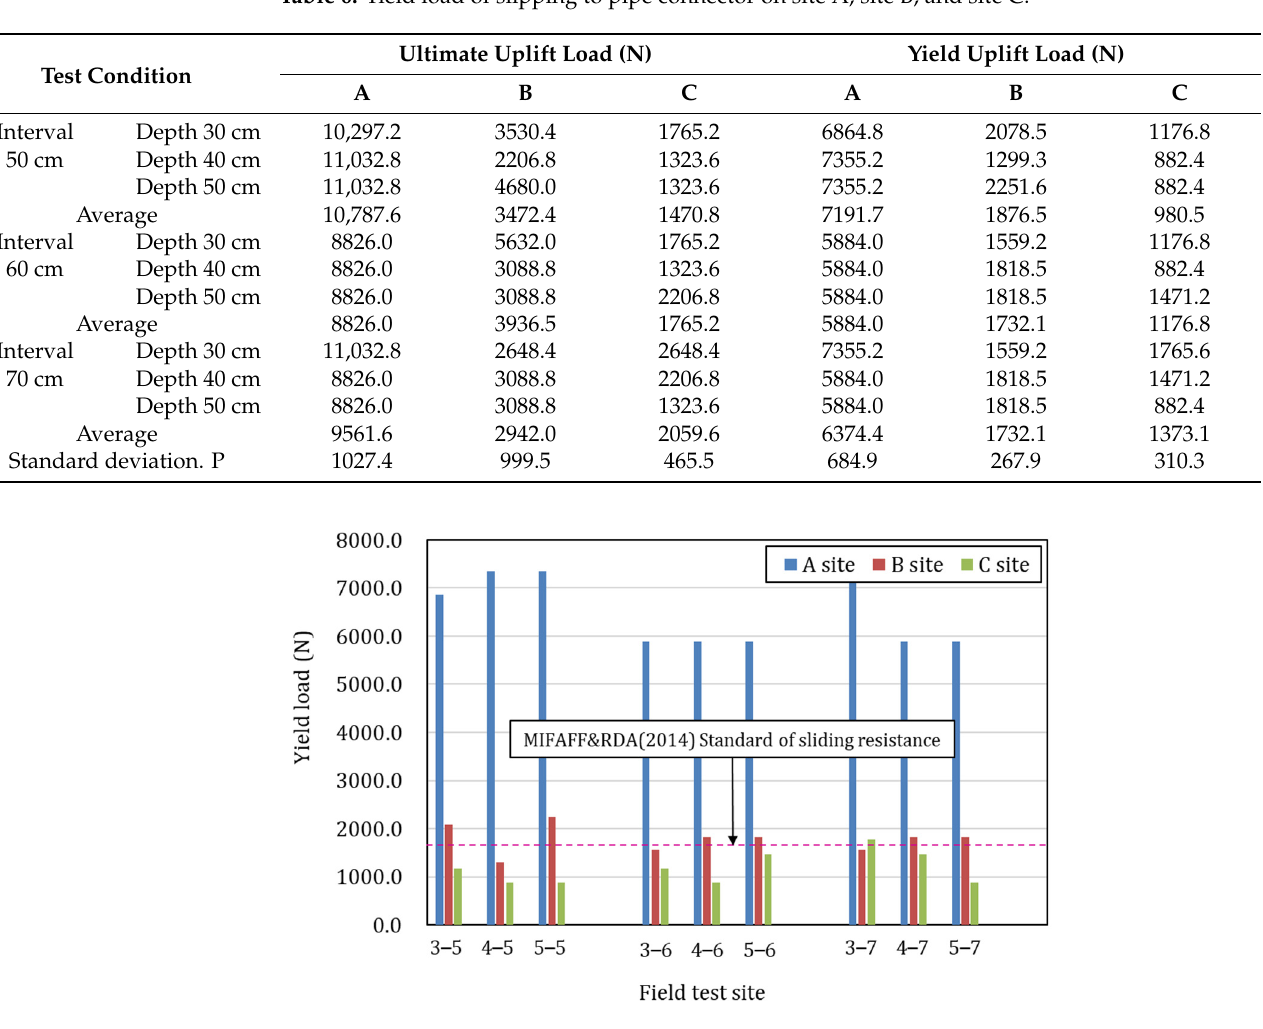
Table 7. Ultimate uplift capacity according to pipe connector type [23].